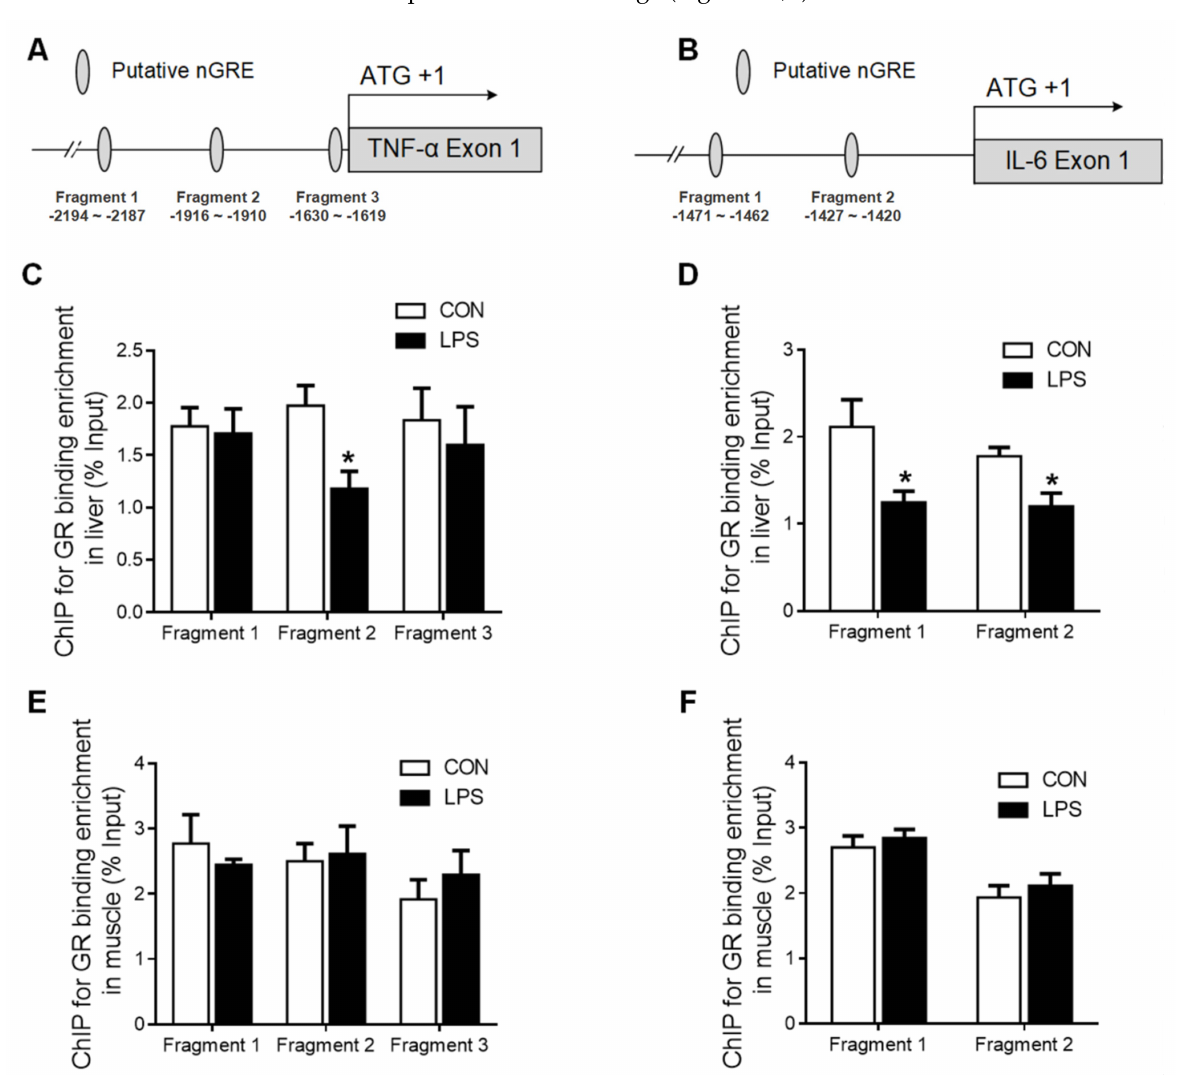
Figure 6. GR binding to TNF- α and IL-6 gene promoters in liver and muscle. ( A ) The putative fragment nGRE site on the promoter region of TNF- α . ( B ) The putative fragment nGRE site on the promoter region of IL-6. ( C ) ChIP analyses GR binding to nGRE sites on the promoter of TNF- α exon 1–4 and 1–9/10 in the liver. ( D ) ChIP analyses GR binding to nGRE sites on the promoter of IL-6 exon 1–4 and 1–9/10 in the liver. ( E ) ChIP analyses GR binding to nGRE sites on the promoter of TNF- α exon 1–4 and 1–9/10 in muscle. ( F ) ChIP analyses GR binding to nGRE sites on the promoter of IL-6 exon 1–4 and 1–9/10 in muscle. Values were expressed as means SEM, n = 4 in each group, * p < ± 0.05.